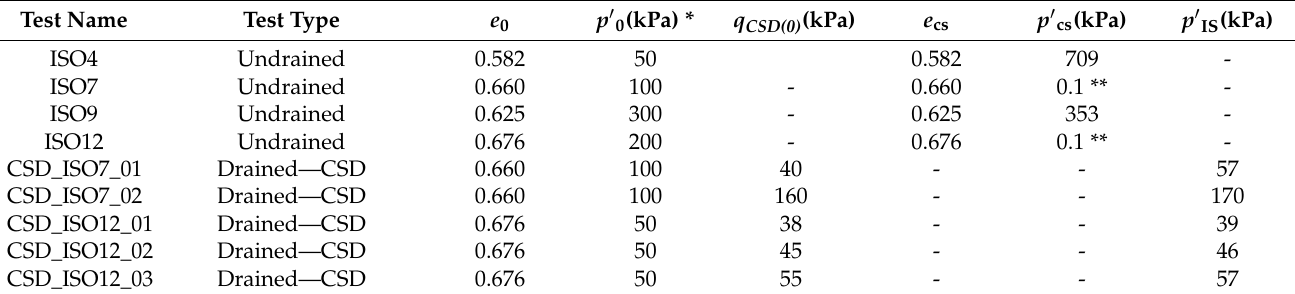
Table 1. The details of DEM simulations used in this